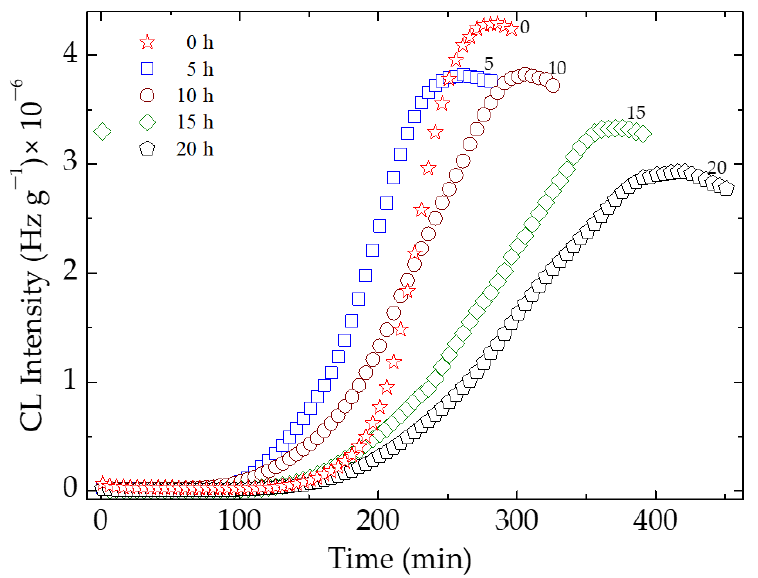
Figure 5. Isothermal CL spectra for neat SIS samples after their thermal treatment at 80 ◦ C for various heating times. Heating temperature: 80 ◦ C. Testing temperature: 130 ◦ C. The mentioned figures denote the time of thermal treatment.